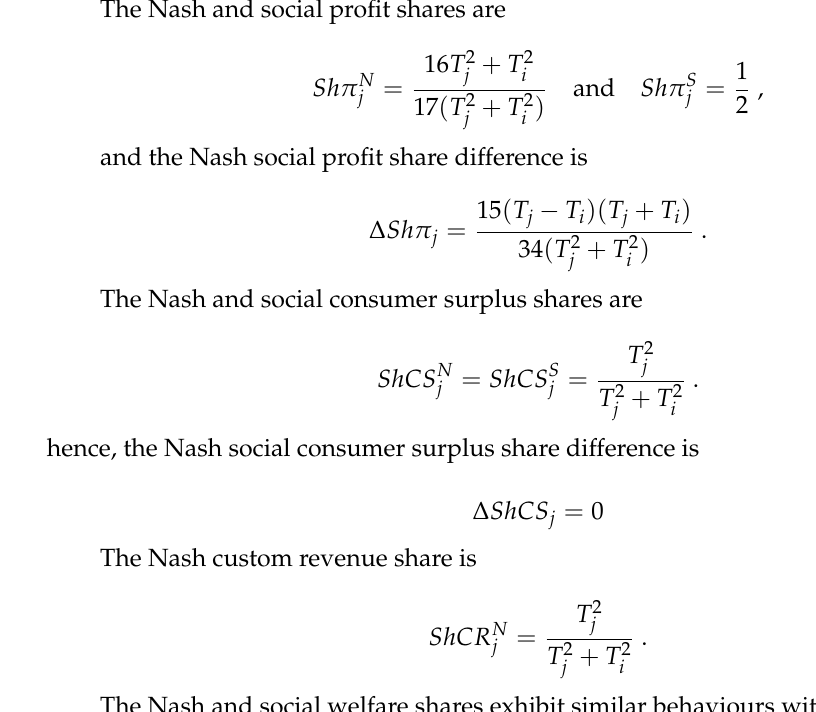
of country X j . Right : The social welfare share ShW S j